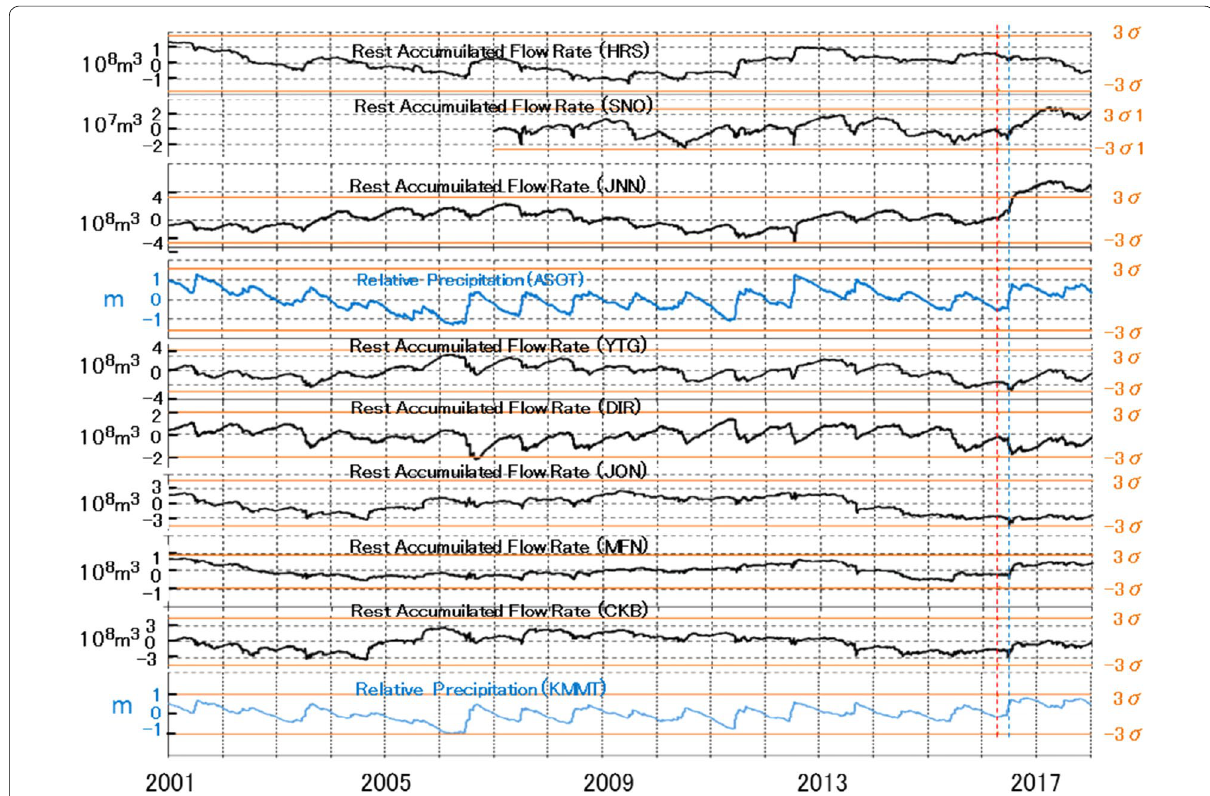
Fig. 5 Temporal change in the rest accumulated flow rate and relative precipitation from 2001 to 2017. σ is the standard deviation from 2001 to 2015. σ 1 at SNO is the deviation from 2007 to 2015. Vertical red and blue broken lines indicate the occurrence of the main shock of the 2016 Kumamoto earthquake and of the heavy rainfall 2 months after it, respectively